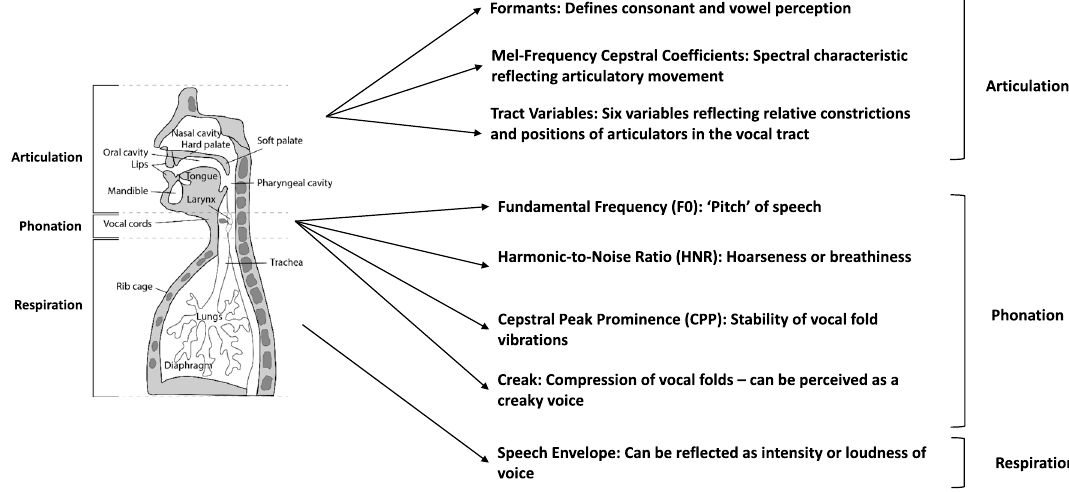
Figure 1. Speech production subsystems and representative acoustic features. Acoustic and articulatory features extracted from audio recordings, as well as their physiological and perceptual